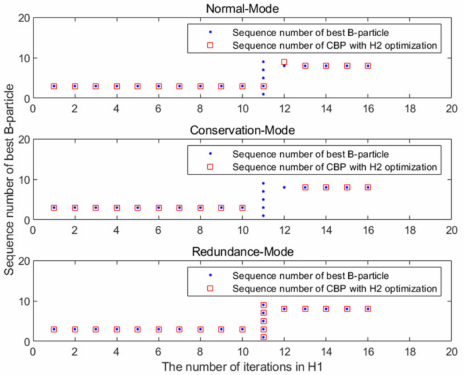
Figure 8. Alternation of L1 and the comparison of three modes ( a ) sequence number of the best B- particle in H1 iteration; ( b ) Local diagram of the sequence number of B-particle with H2 optimization in three modes.